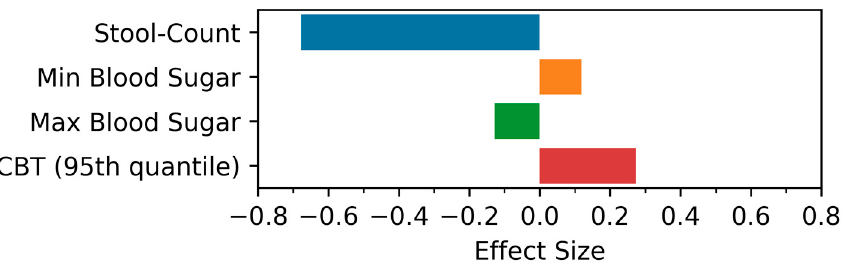
Figure 9. The effect size for the Wilcoxon signed-rank test between the intervention and control period for symptom-frequency-based biomarkers after the first or second vaccination.